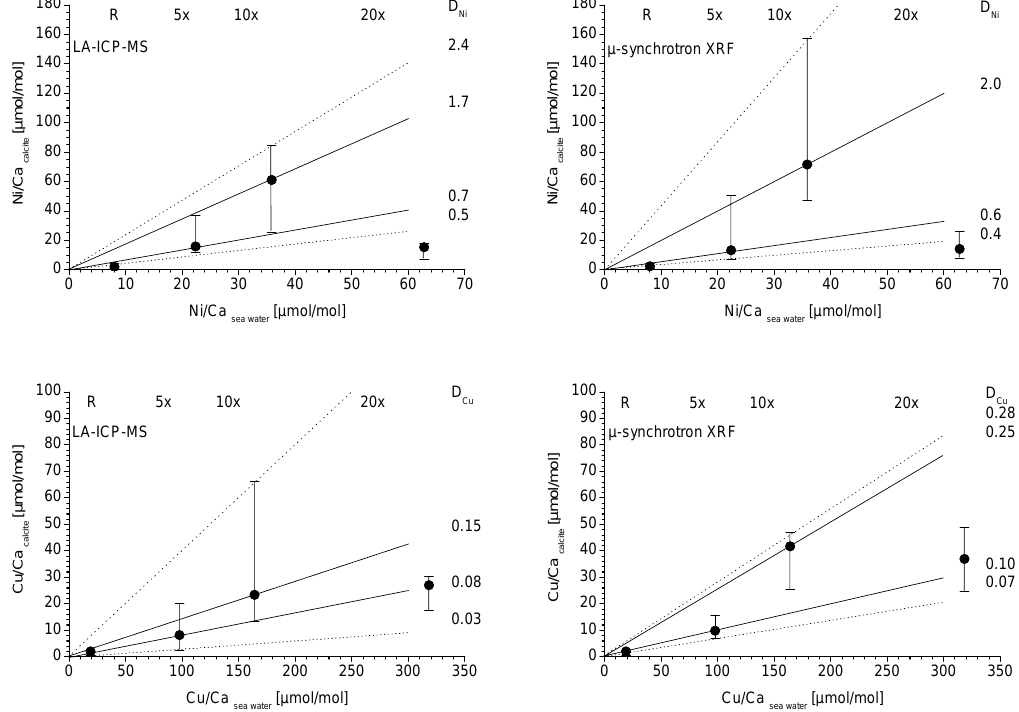
Fig. 5. Calculated partition coefficients of Ni (upper two graphs) and Cu (lower two graphs) – based on LA-ICP-MS (left side) and µ- synchrotron XRF (right side) measurements. The black filled circles ( • ) display the median value of the observed concentration ratios, the short horizontal lines (–) symbolise the 25% (lower line) and the 75% quartile (upper line). Solid lines show the range in median values for reference, 5-, and 10-fold concentration solutions; dotted lines display the upper and/or lower quartiles and mark the area of uncertainty.